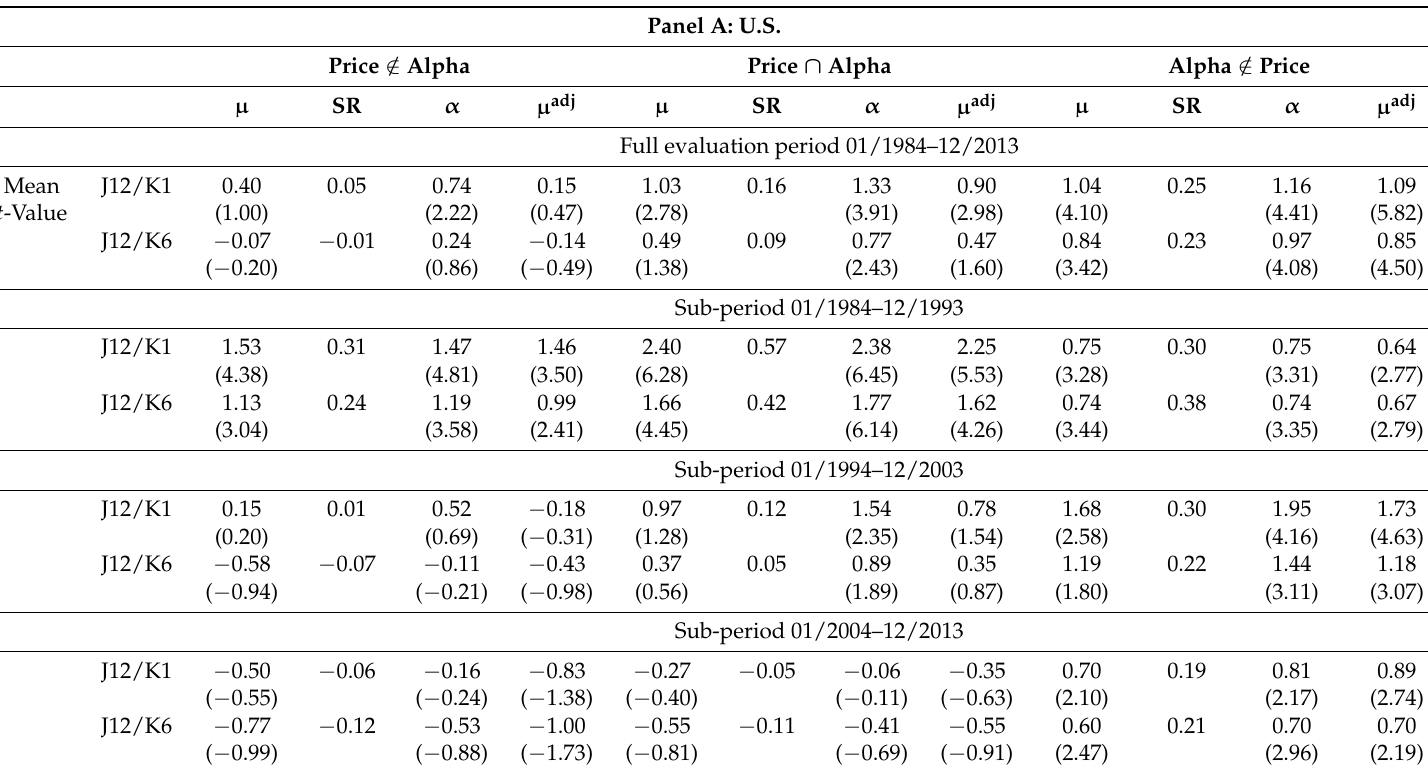
Table 6. Monthly performance of different subset